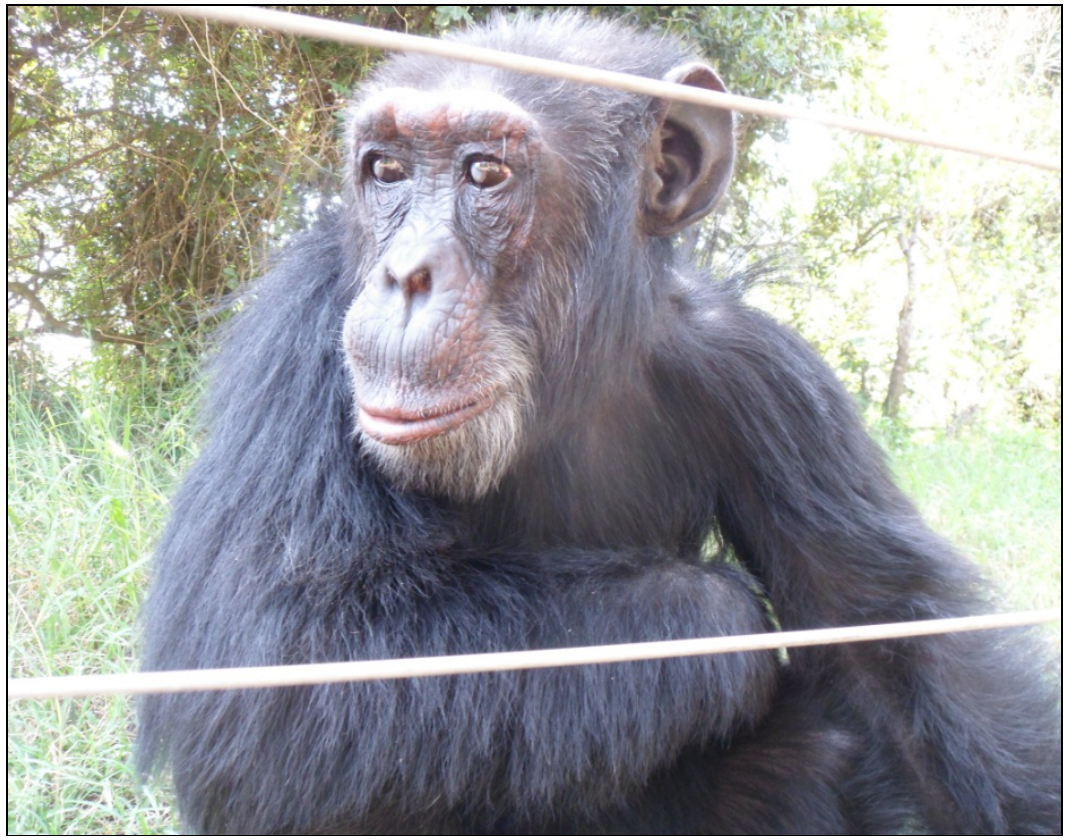
Figure 1. Poco at Sweetwaters Chimpanzee Sanctuary in Kenya in 2011.